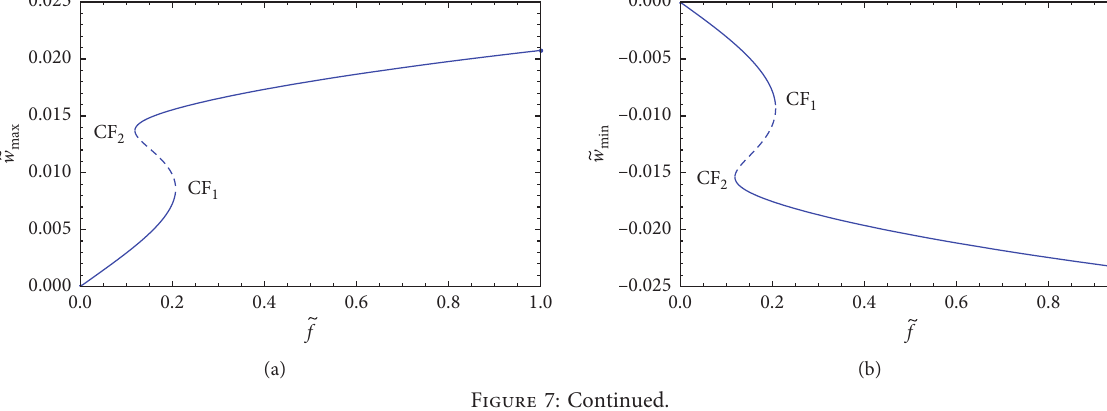
� 􏽥 c � 0 . 05, and 􏽥 f � 0 . 2. (a) m d r